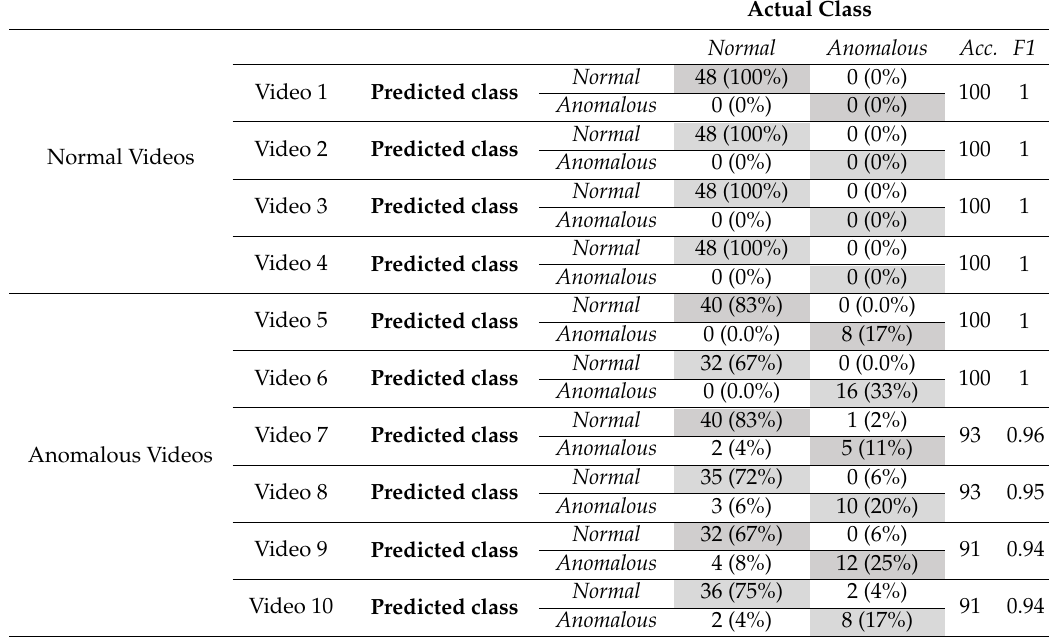
Figure 6. Detected leakage in test videos using the proposed multi Kalman filter method in six subsequent frames ( a )–( f ) in Video 6. The green circles show the matched points between positions predicted by Kalman filters and the measured possible positions in test data. The red circles show the current position of the leakage in the each frame. Table 4. Actual class, predicted class, and accuracy (acc. in percentage) of the classification for test videos, proposed multi Kalman filter. In this table, Normal represents a region (block) without leakage (positive) and Anomalous represents a region (block) with leakage (negative). Shading is to di ff erentiate the rows. Actual